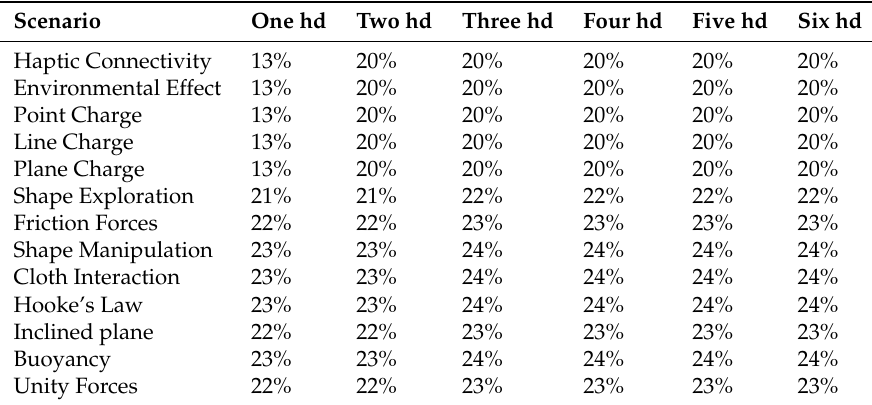
Table 2. Results obtained in the CPU utilization test using one to six haptic devices (HDs). Scenario One hd Two hd Three hd Four hd Five hd Six hd Haptic Connectivity 10% 11% 11% 12% 13% 14% Environmental Effect 10% 11% 11% 12% 13% 14% Point Charge 10% 11% 11% 12% 13% 14% Line Charge 10% 11% 11% 12% 13% 14% Plane Charge 10% 11% 11% 12% 13% 14% Shape Exploration 10% 11% 12% 13% 14% 15% Friction Forces 13% 13% 14% 15% 16% 16% Shape Manipulation 14% 15% 15% 16% 16% 17% Cloth Interaction 14% 15% 15% 16% 16% 17% Hooke’s Law 13% 13% 14% 15% 16% 16% Inclined plane 13% 13% 14% 15% 16% 16% Buoyancy 14% 15% 15% 16% 16% 17% Unity Forces 13% 13% 16% Table 3. Results obtained in the GPU utilization test using one to six haptic devices (hd). Scenario One hd Two hd Three hd Four hd Five hd Six hd Haptic Connectivity 13% 20% 20% 20% 20% 20% Environmental Effect 13% 20% 20% 20% 20% 20% Point Charge 13% 20% 20% 20% 20% Line Charge 13% 20% 20% 20% 20% 20% Plane Charge 13% 20% 20% 20% 20% 20% Shape Exploration 21% 21% 22% 22% 22% 22% Friction Forces 22% 22% 23% 23% 23% 23% Shape Manipulation 23% 23% 24% 24% 24% 24% Cloth Interaction 23% 23% 24% 24% 24% 24% Hooke’s Law 23% 23% 24% 24% 24% 24% Inclined plane 22% 22% 23% 23% 23% 23% Buoyancy 23% 24% Unity Forces 22%